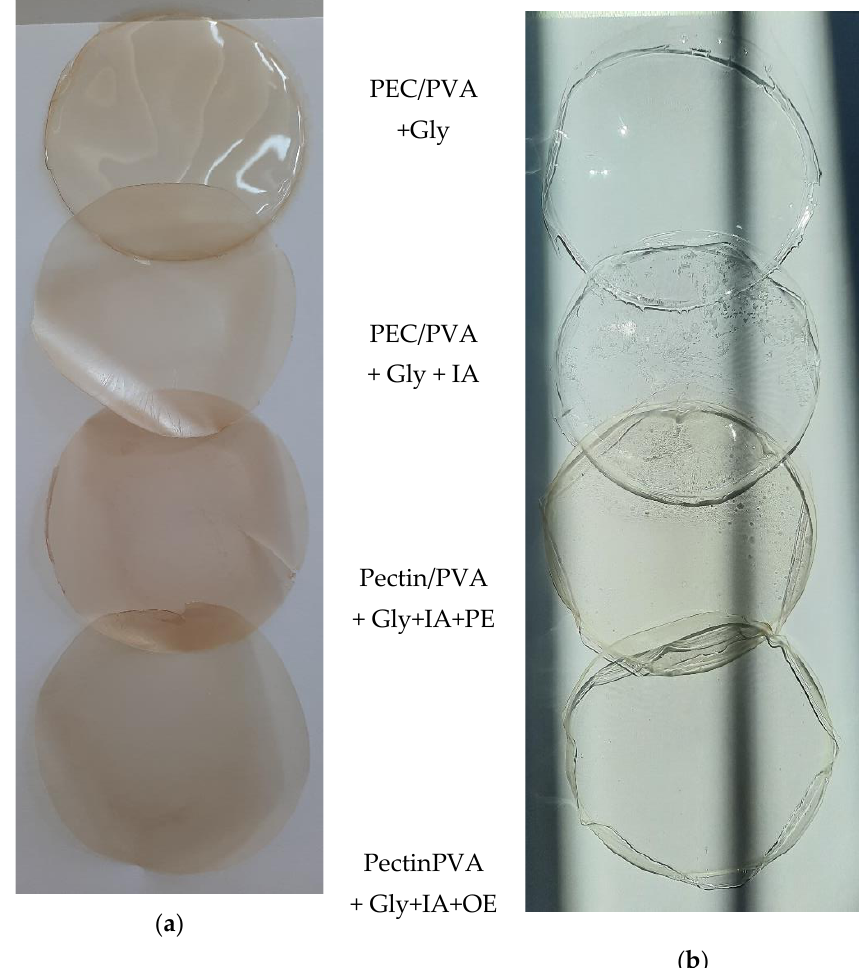
Figure 3. The physical aspect of the solid films with ( a ) pectin, and ( b ) PVA based on itaconic acid and extract integration. Table 4. Thickness, diameter, mass, and density of